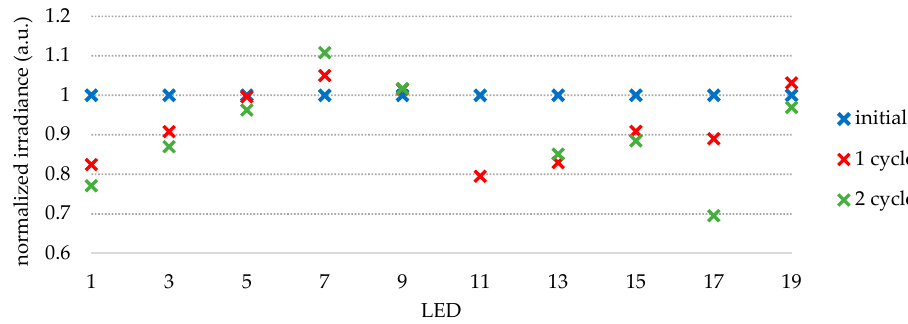
Figure 12. LED irradiance before and after the degradation cycles, normalized to their initial values. Degradation was strongest for the LEDs that were operated at the highest currents (1 and 17).